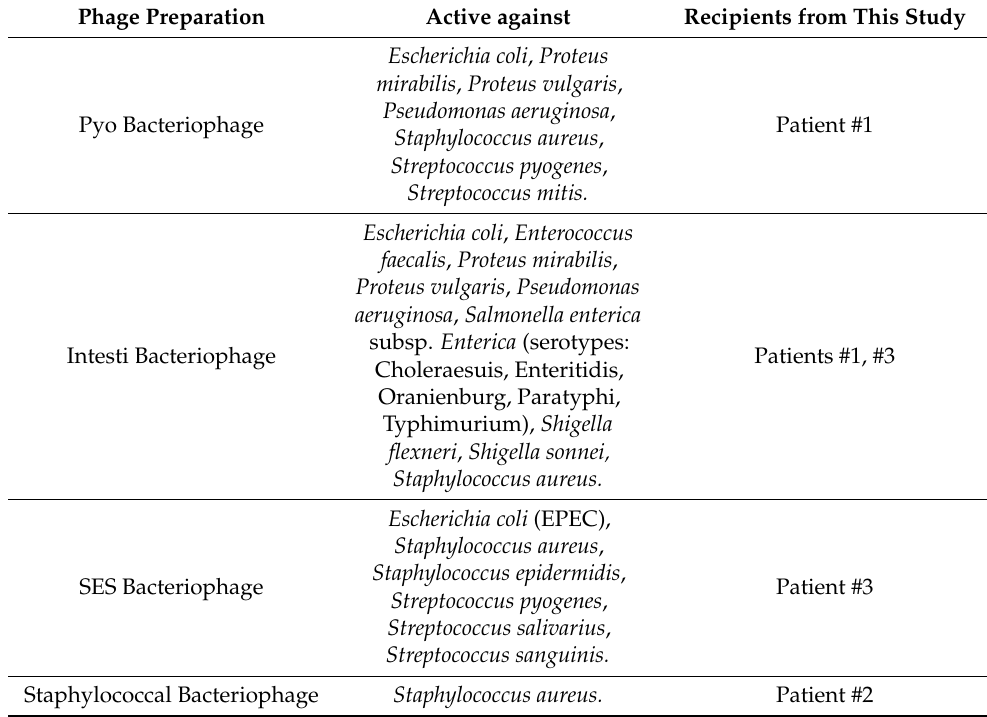
Table 1. Four phage preparations used in this study. Listed preparations are manufactured by Eliava Biopreparations. Bacterial species targeted by these readily available preparations are shown in column 2. The titer of each phage component in these preparations is 10 5 PFU/mL except for Streptococcal phages (10 4 PFU/mL) and for the Staphylococcal phage in the Staphylococcal Bacteriophage preparation (10 7